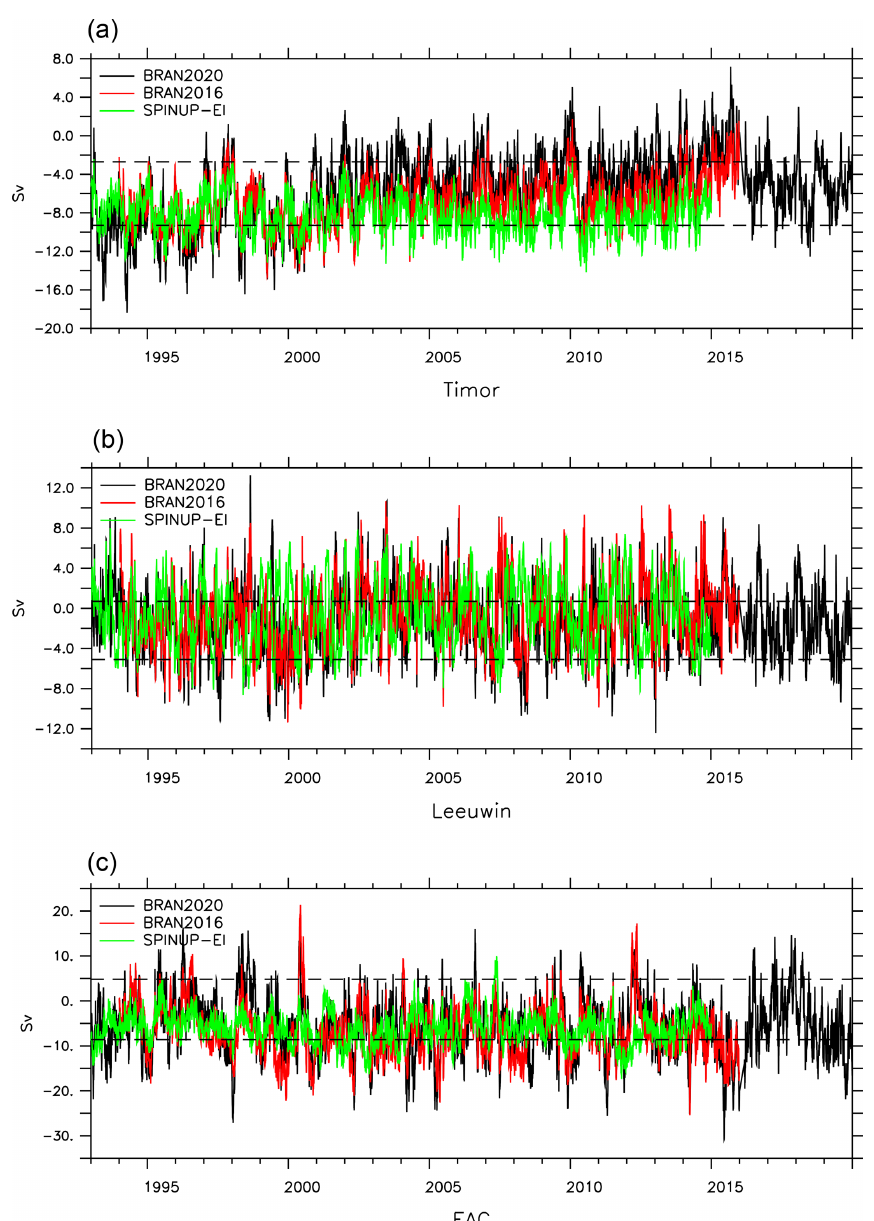
Figure 13. Time series of volume transport in the Timor Sea (a) , the Leeuwin Current at 30 ◦ S (b) and the East Australian Current at 42 ◦ S (c) for BRAN2020, BRAN2016 and the free-running model